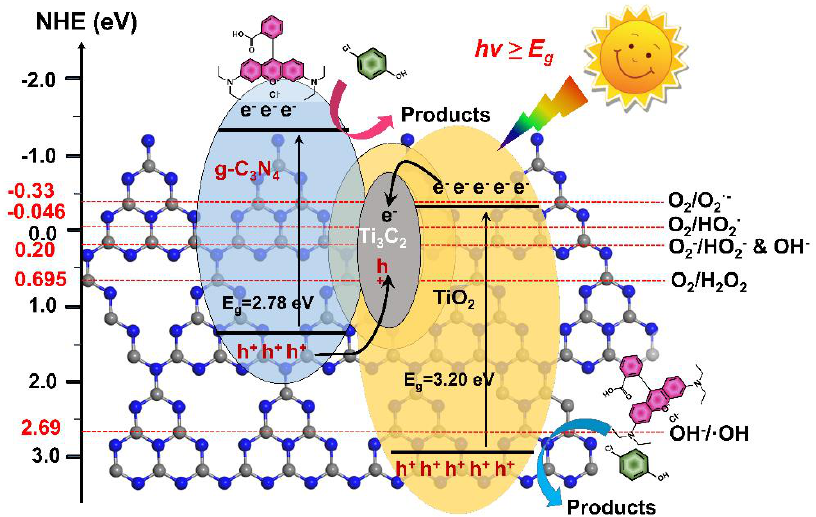
Figure 11. Schematic photocatalytic degradation mechanism over 5TC-TBCN.